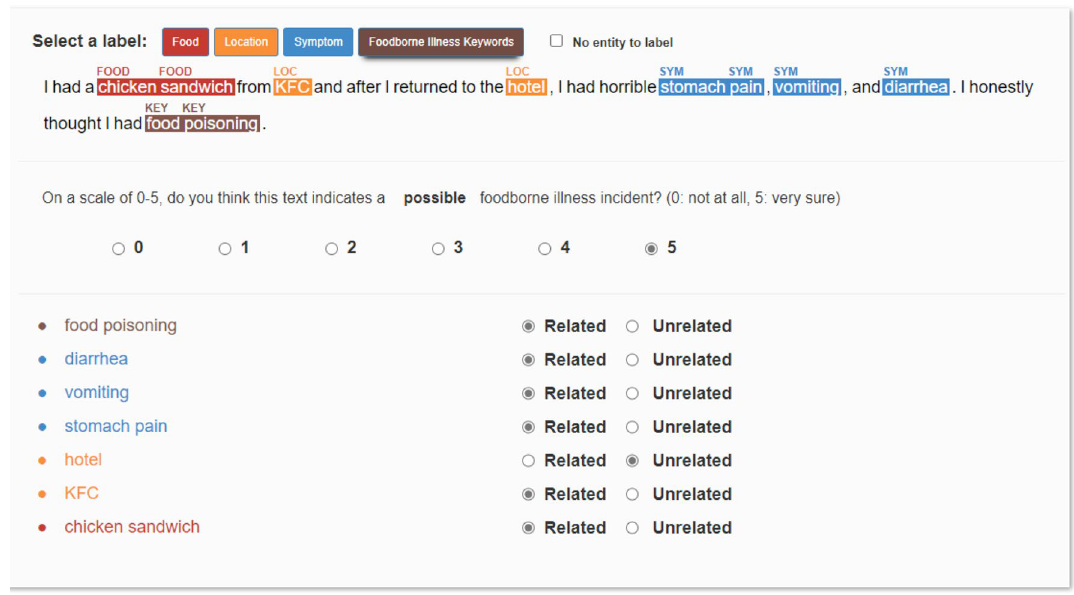
Figure 1. User interface used for data collection on Amazon Mechanical